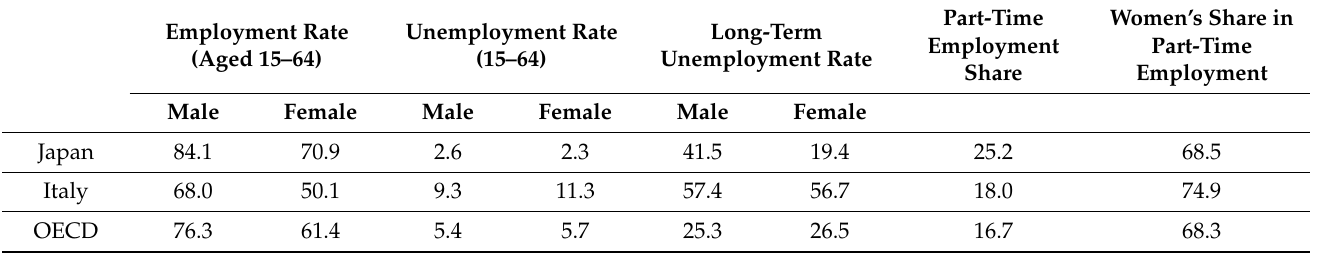
Table 5. Share of Labour force, Unemployment, Long-term Unemployment and Part-time Employ- ment (%) in 2019 in Japan and